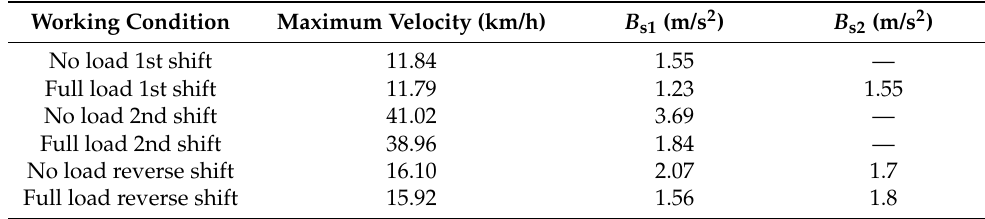
Table 2. Brake strength for the loader.